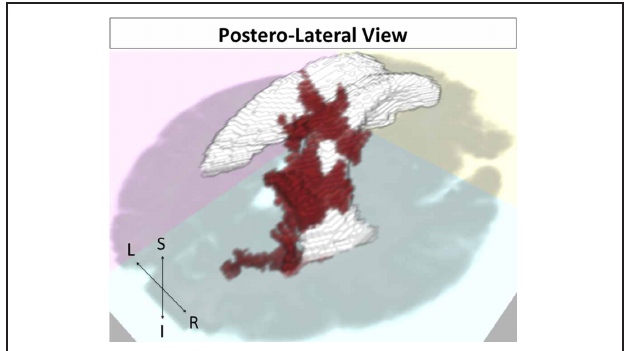
FIGURE 5 | FA cluster related to episodic accuracy among older adults. Cluster in red, ventricles in white, and axial slice in gray for reference. Postero-lateral view.